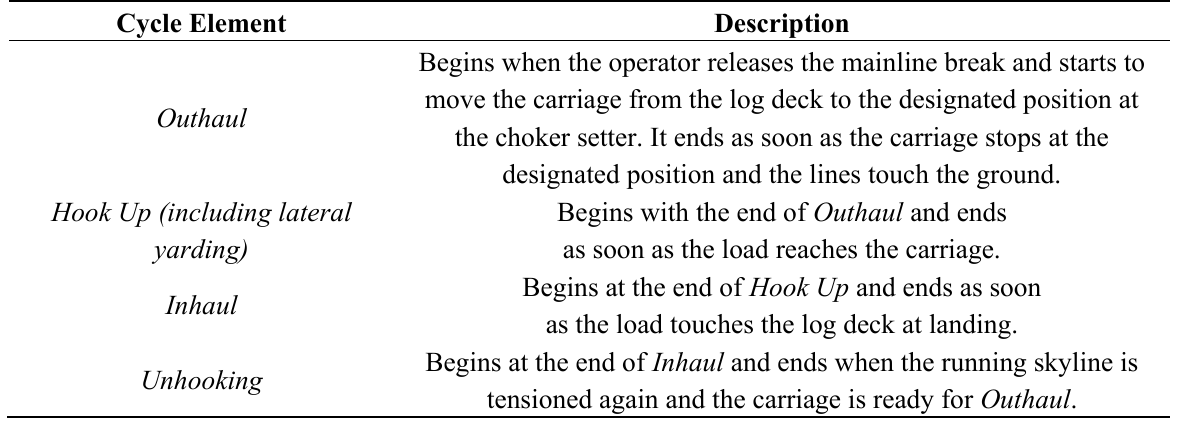
Table 3. Timed yarding cycle